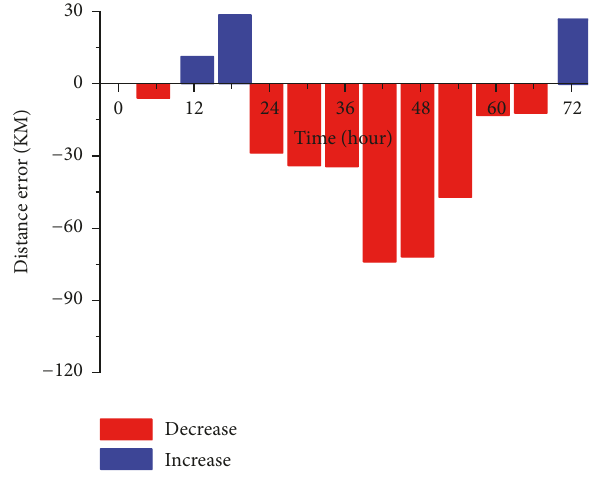
Figure 14: Improvement of TC track (unit: Km) (AIRS_GRD-